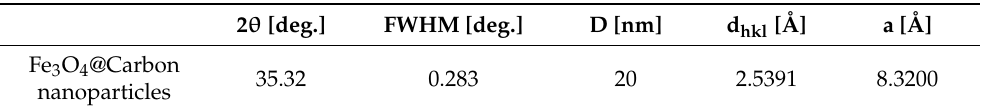
Table 1. Structural parameters of XRD